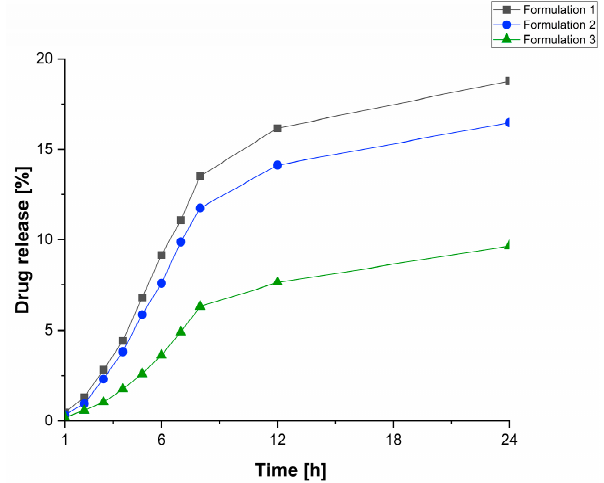
Figure 7. Cumulative release percentage of Fen from formulation 1, formulation 2 and formulation 3 in phosphate buffer media.